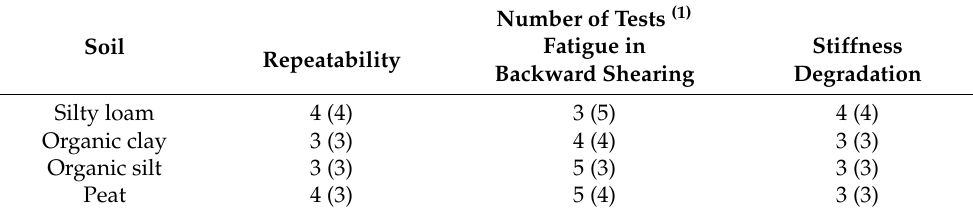
Table 4. Interface shear strength testing